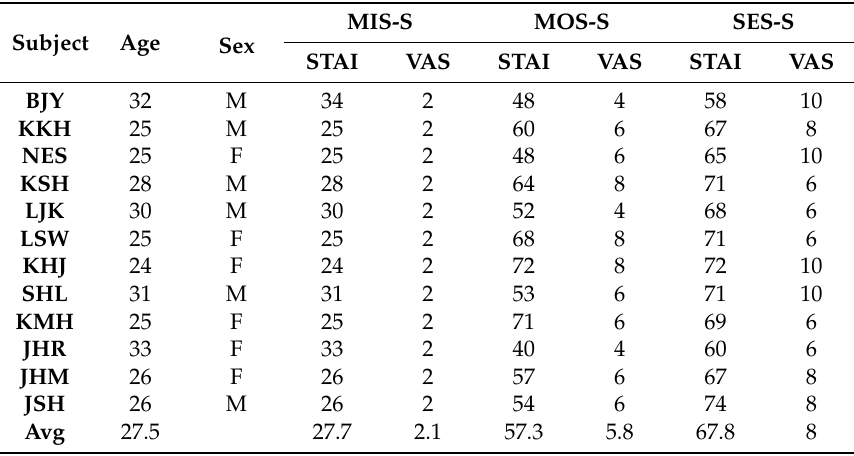
Table 2. Questionnaire score for three different mental